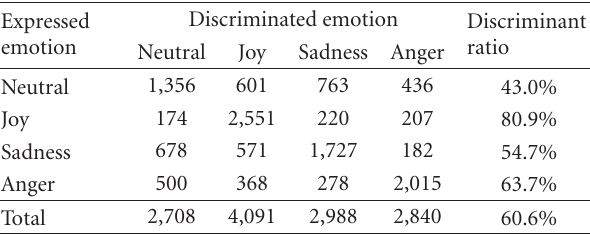
Table 8: Total discriminant ratios of emotion.